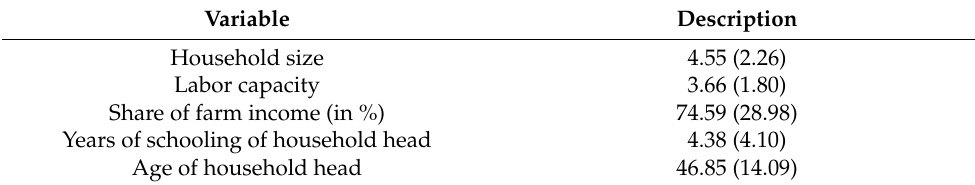
Table 5. Descriptive results: general household characteristics.